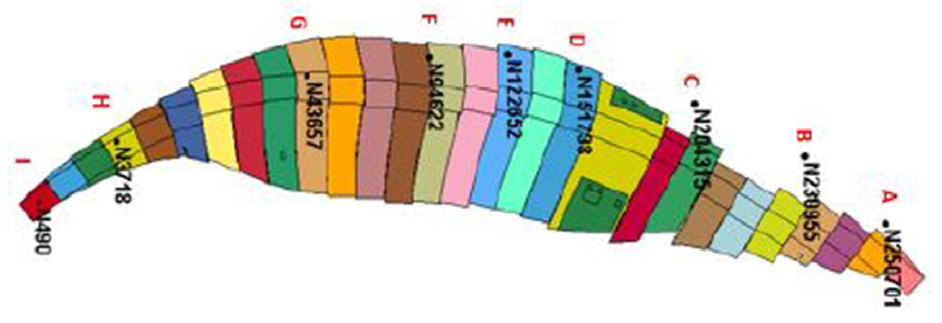
Figure 6. Plan view of dam showing deformed shape (magnification factor of 300) following the 5000-year MYG008 Earthquake. One-year strength parameters. Different colors represent different monoliths within the dam. Letters A through I represent the nodal displacement plot locations shown in Figure 7. Corresponding nodal numbers used to obtain displacement plots from model are listed adjacent to the letters A through I.